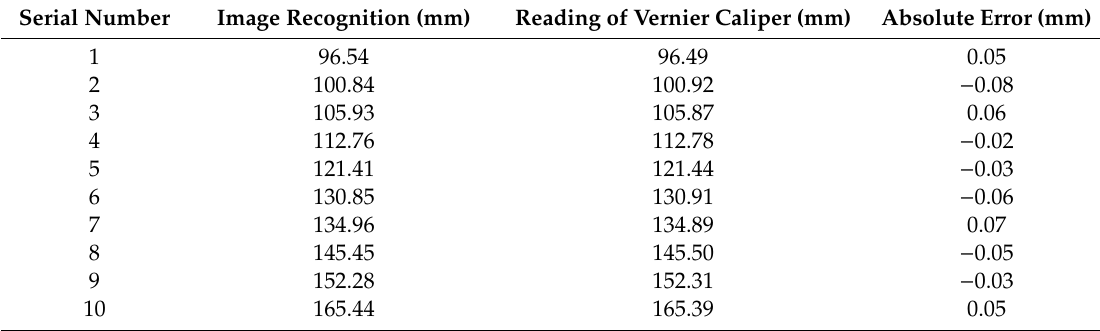
Table 3. A comparison between the proposed liquid level recognition algorithm and manual readings with Vernier